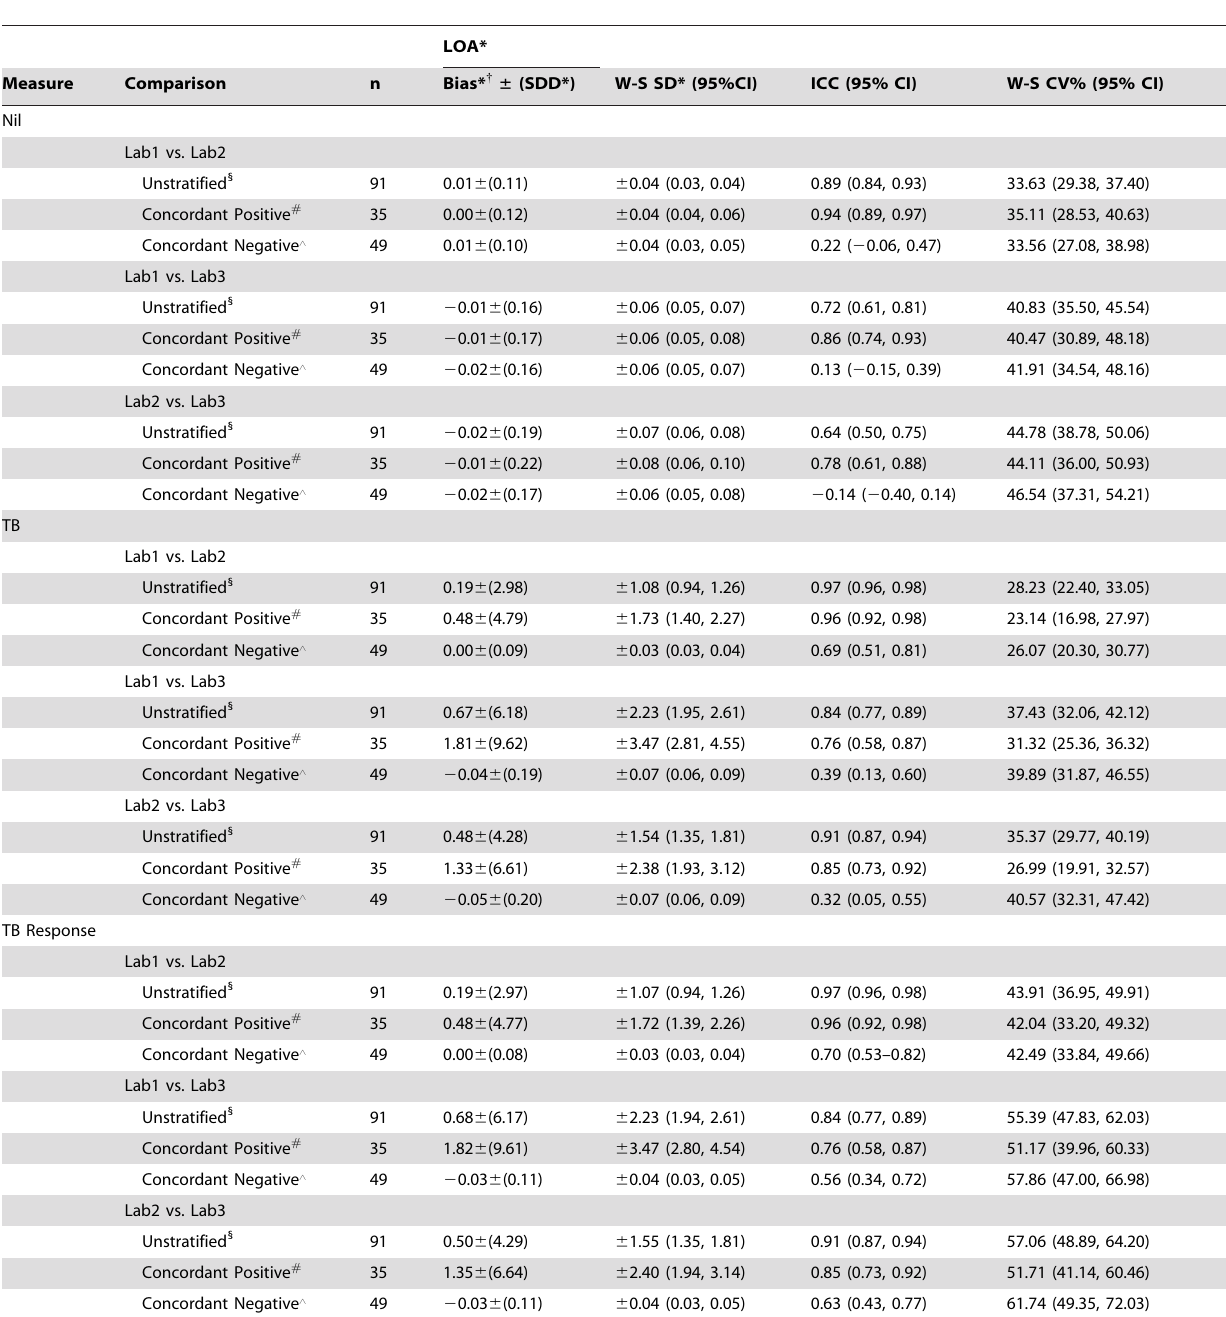
Table 5. Variability in Quantiferon-TB Gold in-Tube test measurements performed on the same subjects in three labs excluding those with extremely high TB